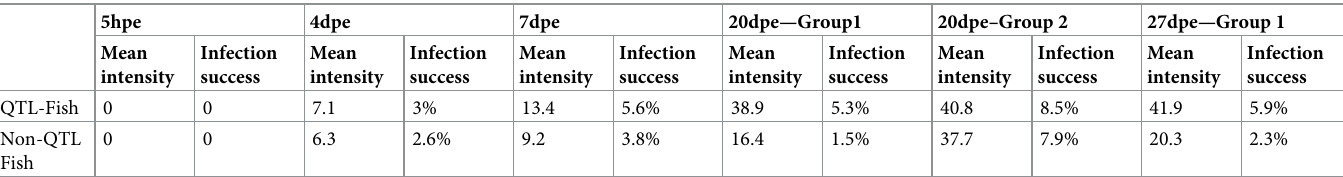
Table 2. Mean intensity (the average number of metacercariae divided by the number of infected fish examined in the sample) and Infection success (the percentage of cercariae that managed to establish as metacercariae in the lens) are shown for QTL and non-QTL fish in 5hpe, 4dpe, 7dpe and 20 dpe fish Group 1 (exposed on days 0 and 10) and Group 2 (exposed on day 10) and 27dpe fish Group